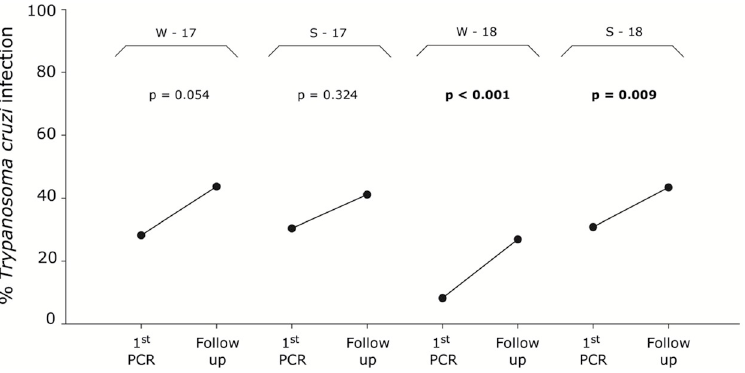
Fig 3. Percentage of Trypanosoma cruzi infection (all development stages combined) in each Mepraia spinolai group (W-17, S-17, W-18, S-18) for the first PCR (+/+) only or follow-up (+/+ and -/+). P-values are shown above each comparison. Statistically significant differences are in bold. (+/-) probably corresponds to bugs that excreted dead parasites in the first PCR (i.e., with T . cruzi DNA remains).